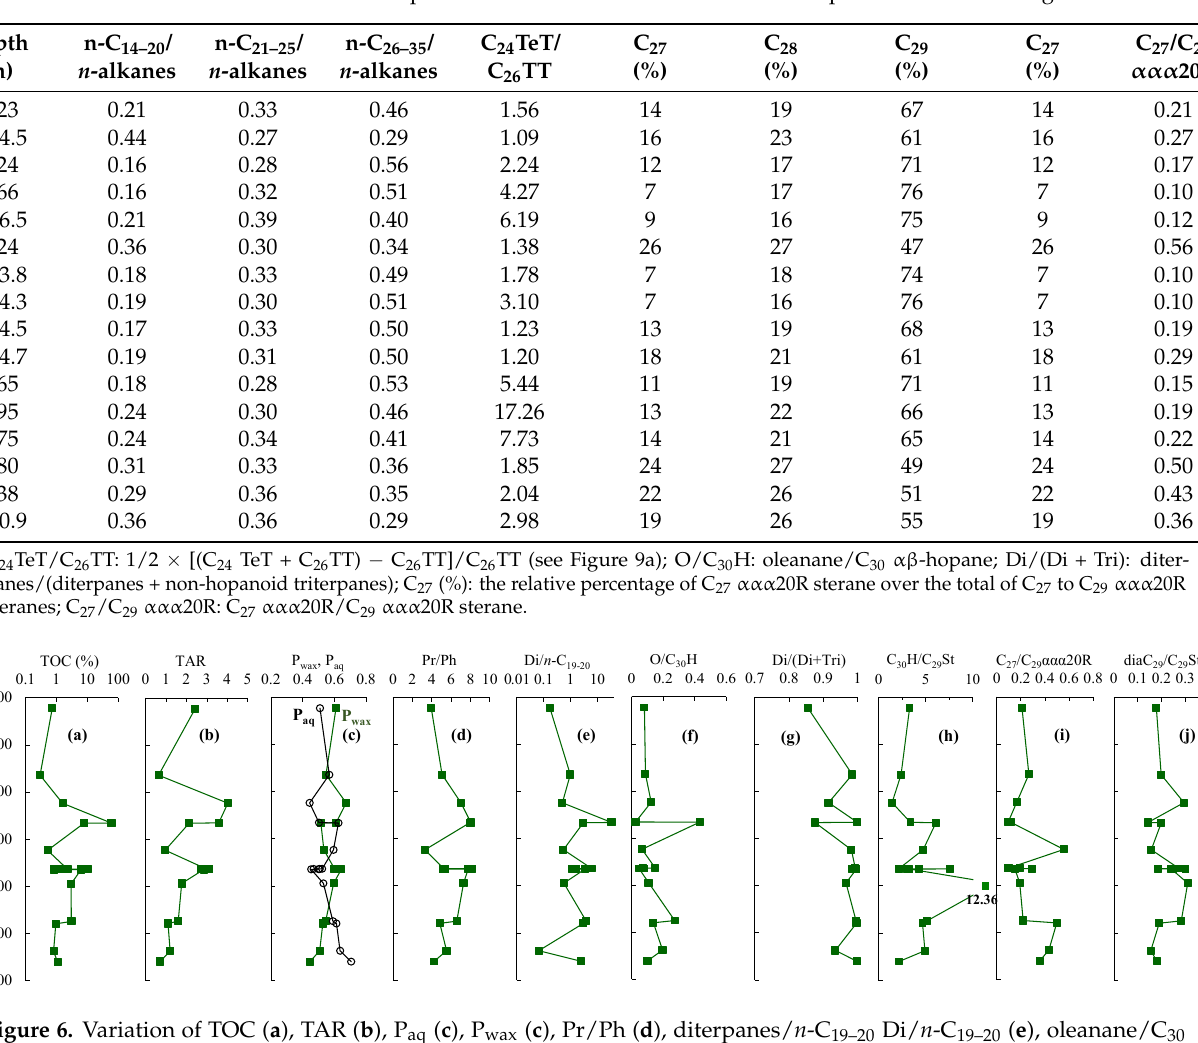
Table 2. Partial source related parameters of the studied source rock samples from the Xihu Sag.